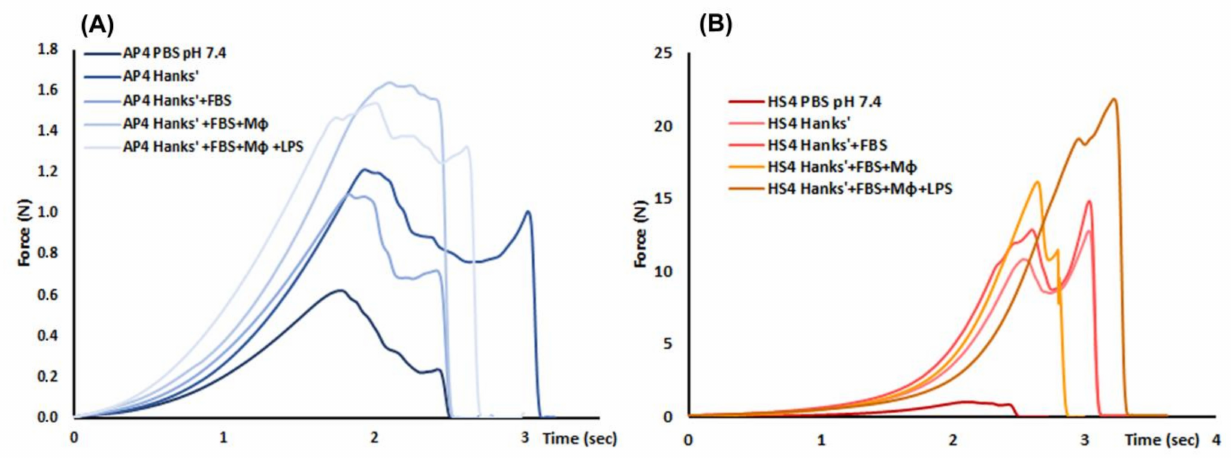
Figure 8. Mean ( n = 15) force overtime curve of the AP4 ( A ) and HS4 ( B ) gel beads incubated in PBS (“PBS pH 7.4”); Hanks’ solution at pH 7.4 (“Hanks’”); Hanks’ solution supplemented with 10% FBS (“Hanks’+FBS”); Hanks’ solution supplemented with 10% FBS and 2 × 10 6 cells/mL peritoneal macrophages (“Hanks’+FBS+M ϕ ”); Hanks’ solution supplemented with 10% fetal bovine serum, 2 × 10 6 peritoneal macrophages, and 10 µ g/mL of LPS (“Hanks’+FBS+M ϕ